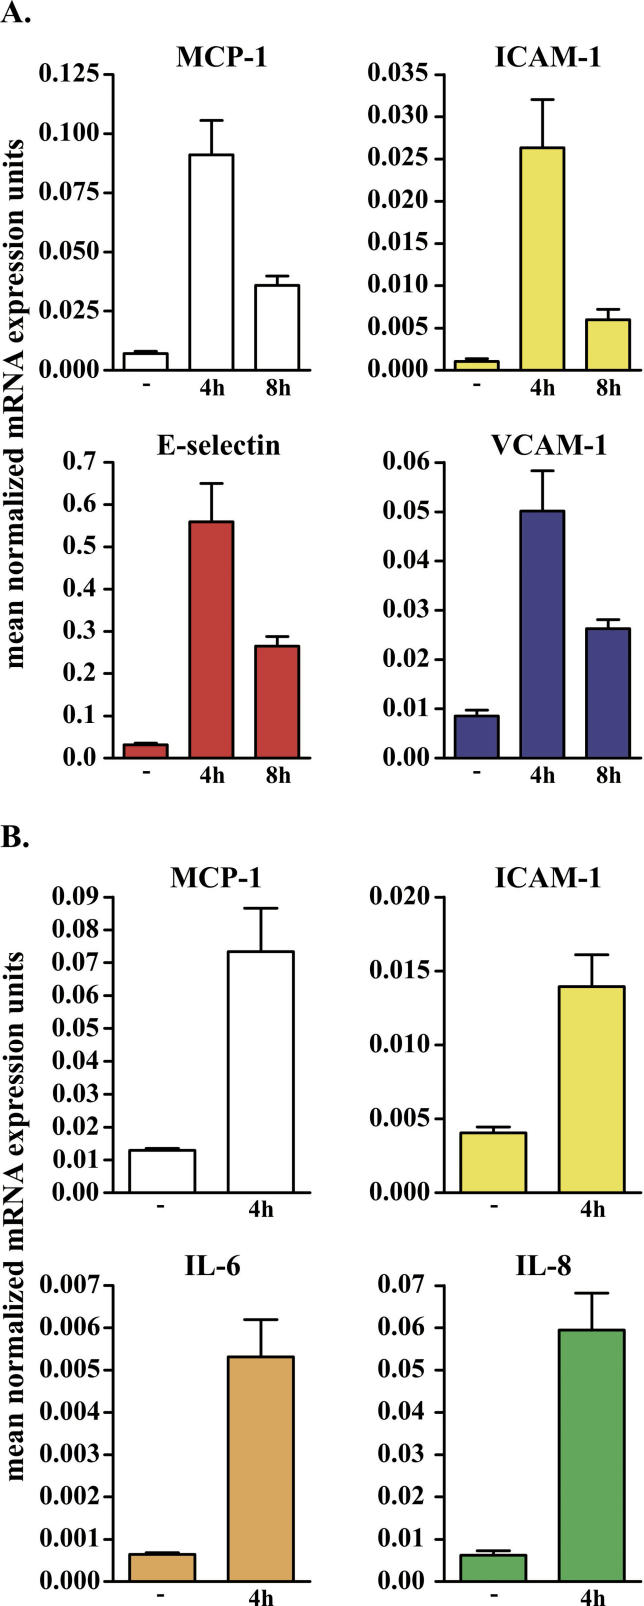
Validation of Gene Array Results by Q-PCRGenes selected for validation by Q-PCR in endothelial cells (A) and fibroblasts (B). MCP-1, ICAM-1, E-selectin, and VCAM-1 transcripts were increased by 12.89-, 25.36-, 17.59-, and 5.86-fold, respectively, in endothelial cells incubated with the antibodies for 4 h compared with control endothelial cells (A). MCP-1, ICAM-1, IL-6, and IL-8 transcripts were increased 5.7-, 3.44-, 9.54-, and 8.22-fold in fibroblasts incubated with the antibodies compared to control fibroblasts (B). The level of transcript expression is reported on the vertical axis. GAPDH was selected as endogenous gene.